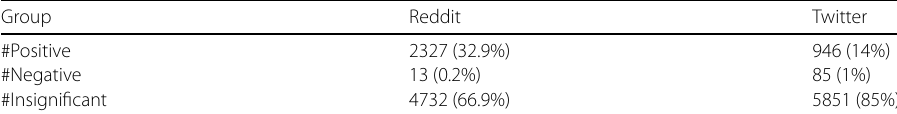
Table 5 Distribution of the susceptibility α i to the community feedback. Positive and negative mean that the susceptibility is significantly higher (lower) than 0, based on 99% confidence interval